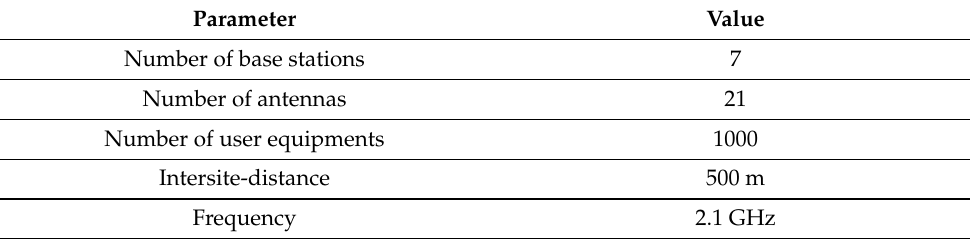
Table A2. The configuration of the antenna tilt